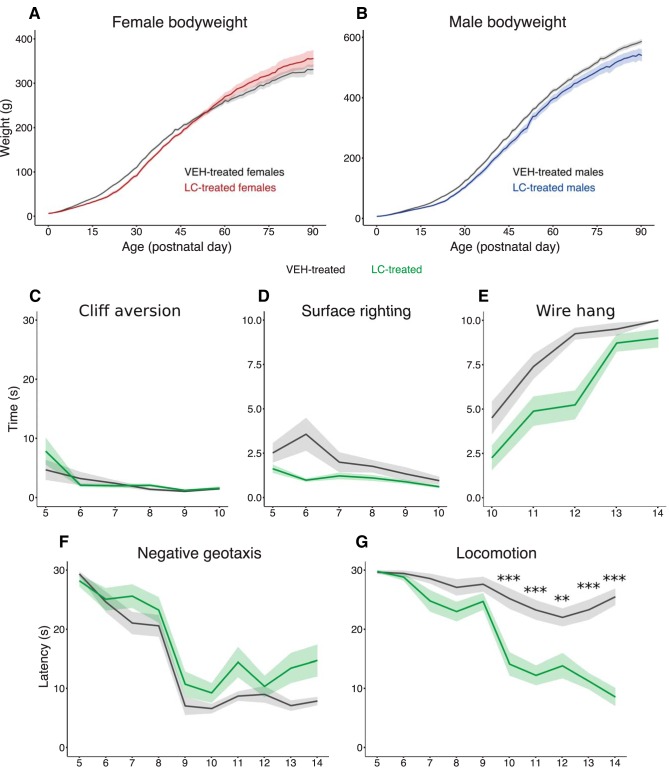
Microglia depletion alters the development of early reflexes, behaviors, and body weight throughout life. Body weight (in grams) in female (a) and male (b) rats measured daily from PN0 to PN90. c, Time (in seconds) for rat pups to retreat from an edge (cliff aversion). d, Time (in seconds) for rat pups to successfully right themselves (surface righting). e, Duration (in seconds) rat pups hung from their forepaws before falling (wire hang). f, Latency (in seconds) for rat pups to reverse orientation and face upward on an incline (negative geotaxis). g, Latency (in seconds) for rat pups to leave a designated area (locomotion). Solid lines indicate group means for VEH-treated (black; a–g) and LC-treated (red; a) females, LC-treated males (blue; b), and LC-treated rats of both sexes (green; c–g). Shaded regions indicate ± SEM. **p < 0.01, ***p < 0.001. n = 18–20 per treatment.